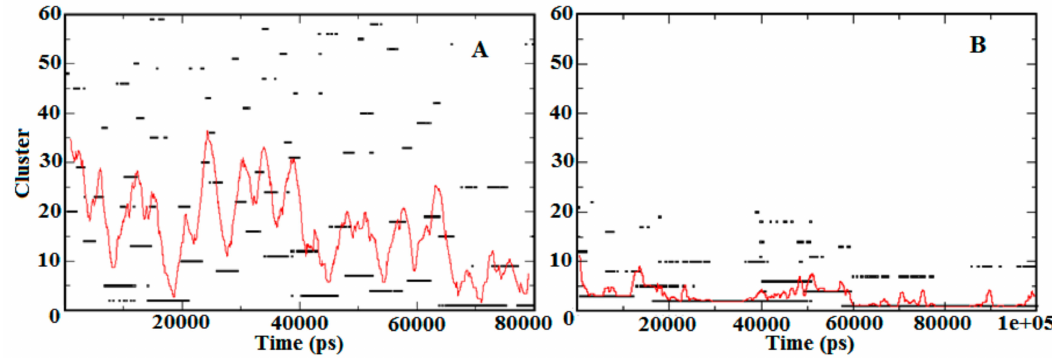
Figure 5. Temporal distribution of the apo-S100A1 and holo-S100A1 state. A denotes cluster distribution approximation of the apo-S100A1 protein, which demonstrates larger clusters by time, and B represents the holo-S100A1 (Ca 2 + loaded) protein illustrating ~20 clusters noted until 60 ns and the remaining 10 clusters in the last 40 ns of simulation. The estimation of cluster analysis is computed using the cut-o ff value of 0.2 nm. The red trace represents the mean cluster value calculated for a 100 ps wide running